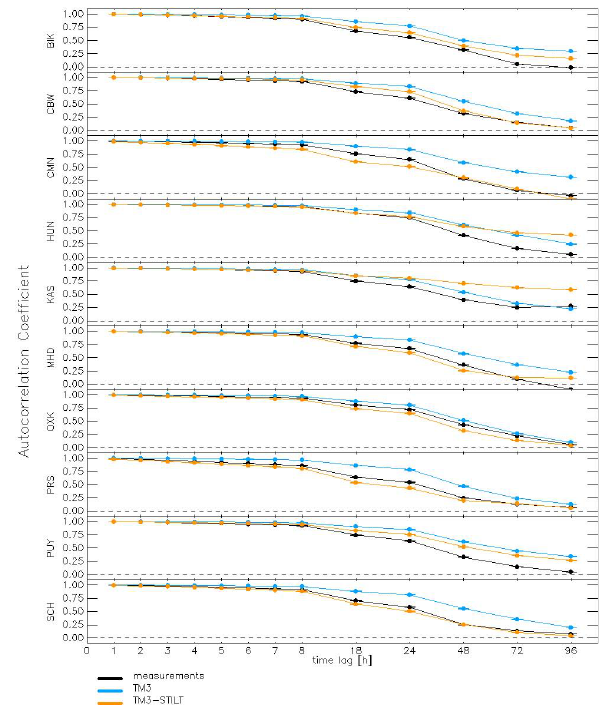
Fig. 4. Autocorrelation coefficients for time series of CO 2 mixing ratio [ppm] measured and modelled at 10 European sites. The time lag of 1, 2, 3, 4, 5, 6, 7, 8, 18, 24, 48, 72, 96h was used for day time values between 10:00 and 17:00. Error bars indicate 95% con- fidence intervals for the estimated autocorrelation